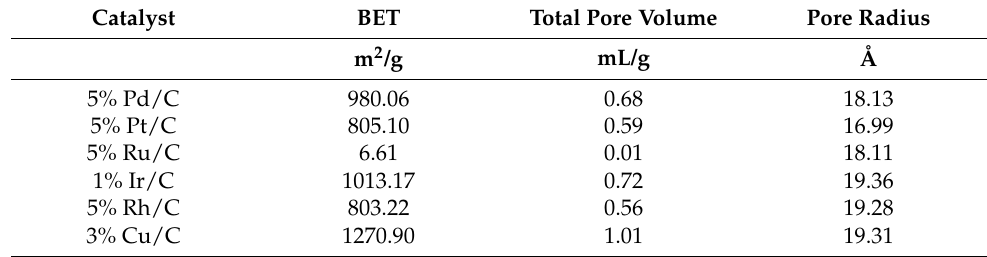
Table 1. Results of the physisorption